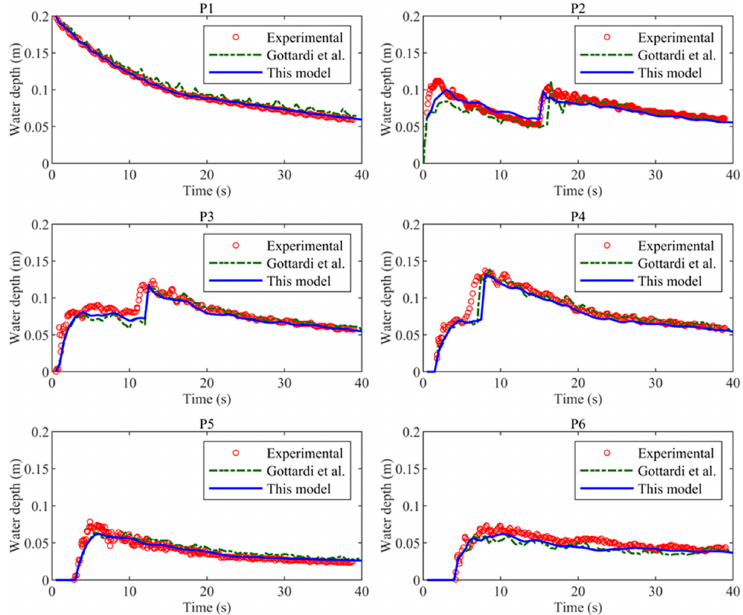
Figure 7. Dam-break flow in a 90 ◦ curved channel: simulated and measured water depth [34].